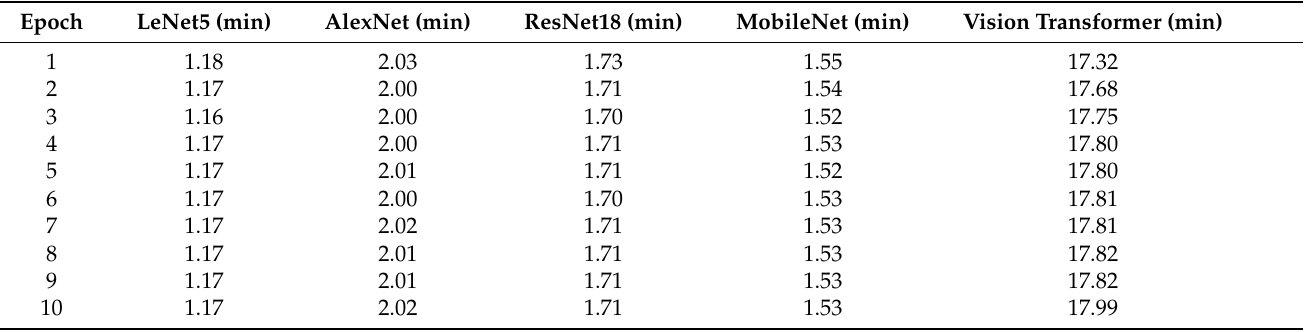
Figure 6. Comparison of the efficiency before data augmentation. ( a ) Comparison of the efficiency of each model before data augmentation and before GPU loading. ( b ) Comparison of the efficiency of each model before data augmentation and after GPU loading. Table 8. Computational efficiency of per epoch operation for each model before data augmentation and after GPU